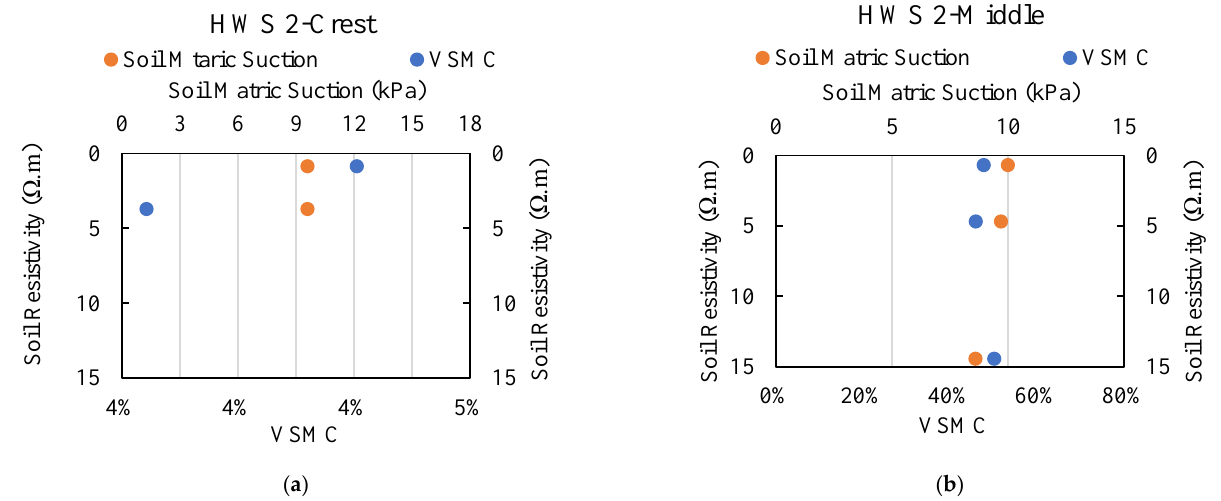
Figure 15. HWS 2 comparison of 2D ERI test profile with field instrumentation ( a ) At crest of the slope ( b ) At middle of the slope (1 m = 3.28 ft; 1 mm = 0.039 in; 1 kPa = 20.89 psf).